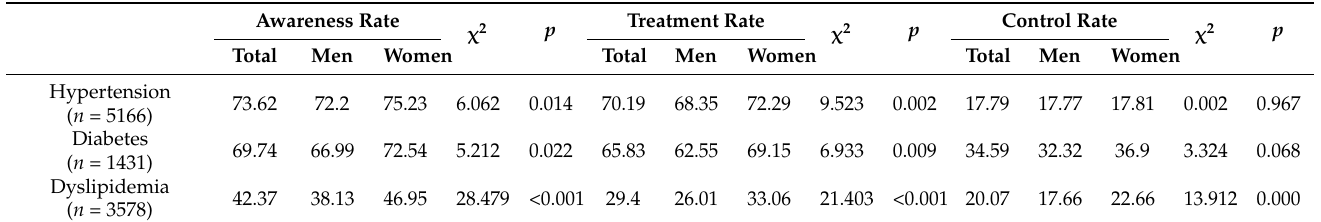
Table 3. Awareness, treatment, and control rate of hypertension, diabetes, and dyslipidemias in stroke patients in China (%).